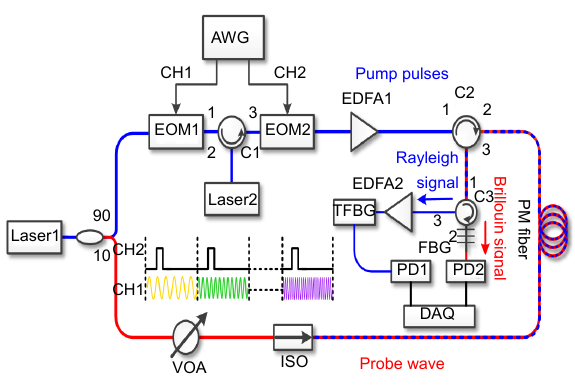
Fig. 4 | The experiment setup of the proposed sensor by com- bining the Rayleigh and Brillouin